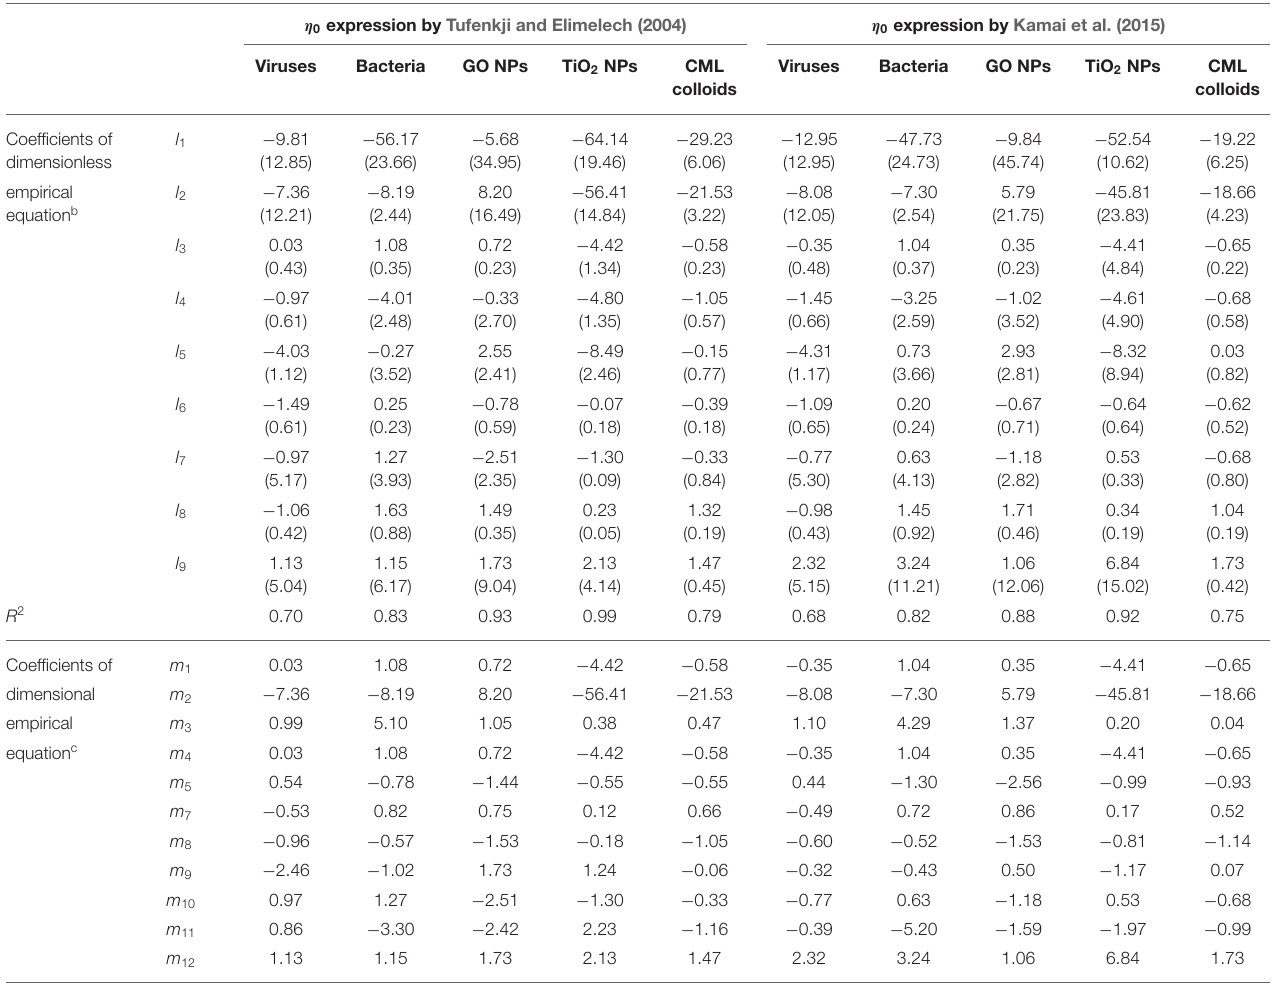
TABLE 9 | Estimated values of coefficients in the empirical equations of α for various colloids a . η 0 expression by Tufenkji and Elimelech (2004) η 0 expression by Kamai et al. (2015) Viruses Bacteria GO NPs TiO 2 NPs CML Viruses Bacteria GO NPs TiO 2 NPs CML colloids